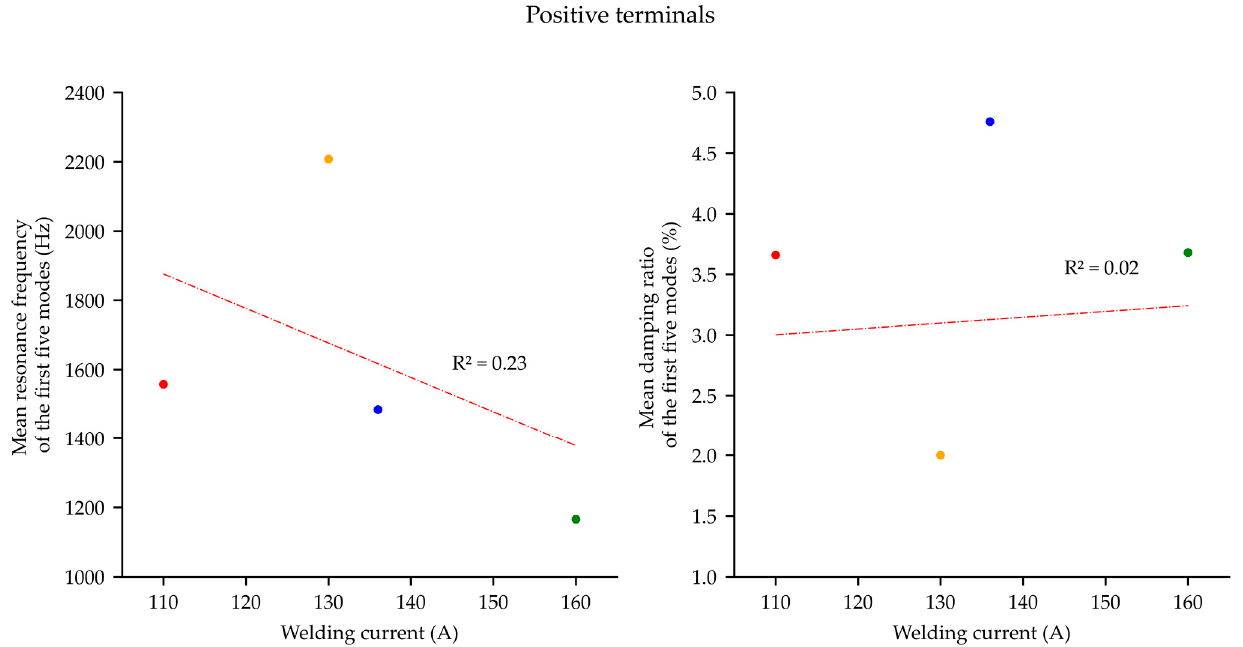
Figure 16. Scatter plots, with the Pearson correlation coefficient, of the mean resonance frequency ( left ) and the mean damping ratio ( right ) of the first five modes, as observed from the positive terminals of the 110 A, 130 A, 160 A, and mixed supercells.